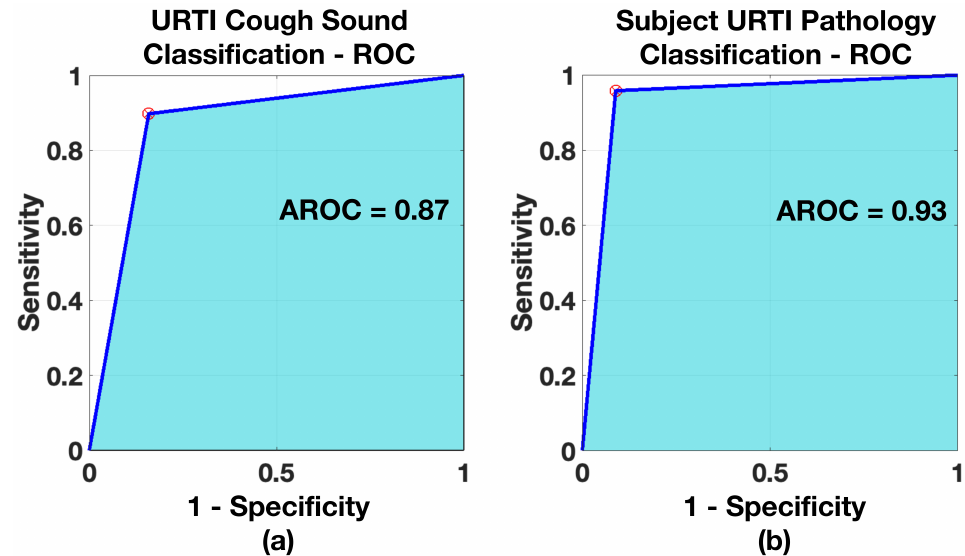
Figure 12. ROC— Healthy vs. URTI Model : ( a ) when classifying URTI coughs, ( b ) when classifying subject for URTI.